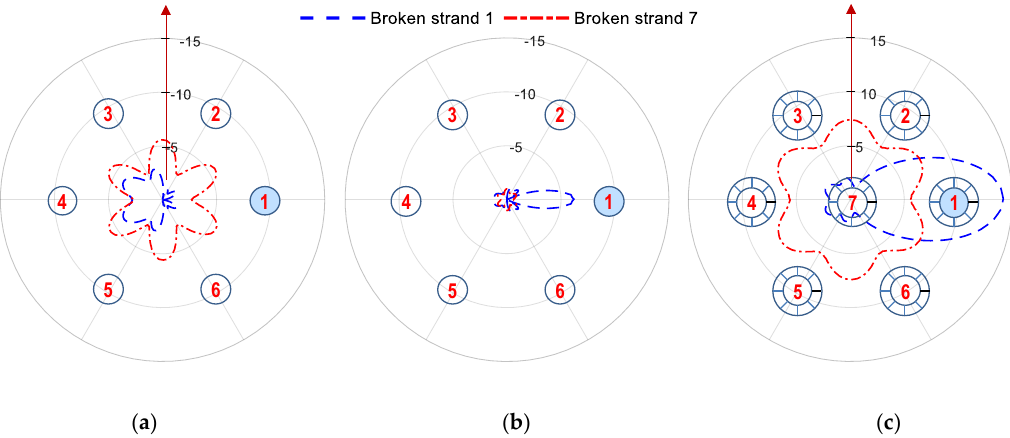
Figure 3. Circumferential stress variation (MPa) at relative heights of the anchor head. ( a ) Near-bottom ( a / H = 0.15), ( b ) middle ( a / H = 0.5), and ( c ) near-top ( a / H = 0.9).